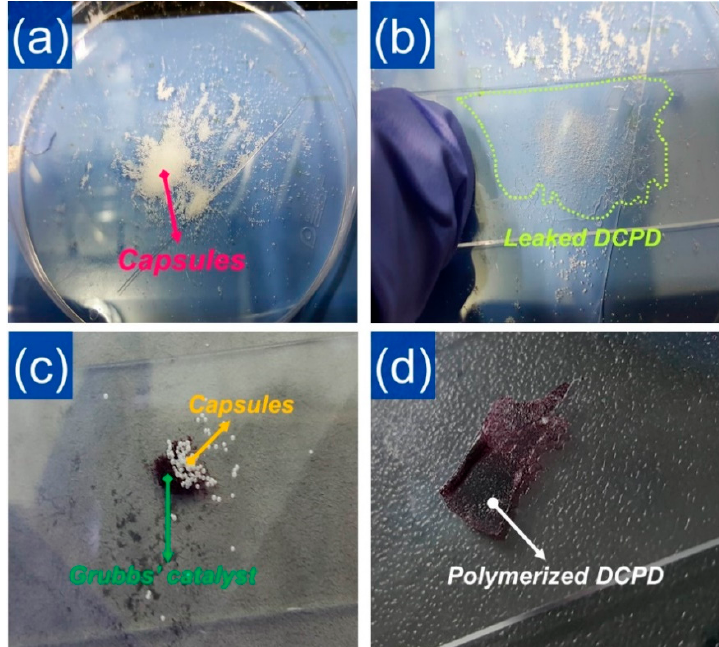
Figure 4. Photo images of ( a ) the prepared powder-like mechanically-enhanced microcapsules, ( b ) the liquid DCPD monomer leaked from the ruptured microcapsules, ( c ) the mixture of the microcapsules and the Grubbs’ catalyst, and ( d ) the solid DCPD formed after 5 h of the reaction between the leaked DCPD and the catalyst.